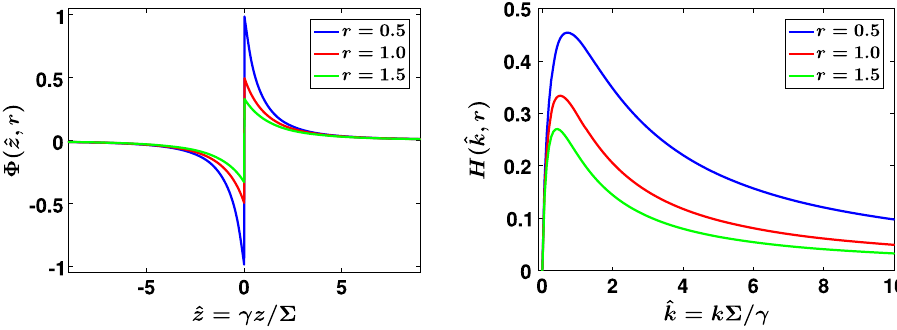
FIG. 2. Left panel: Plot of the interaction function Φ ð ˆ z; r Þ in terms of ˆ z , for three different values of the aspect ratio r . Right panel: Plot ˆ ˆ k; r Þ in terms of k , for the same values of r of the function H ð